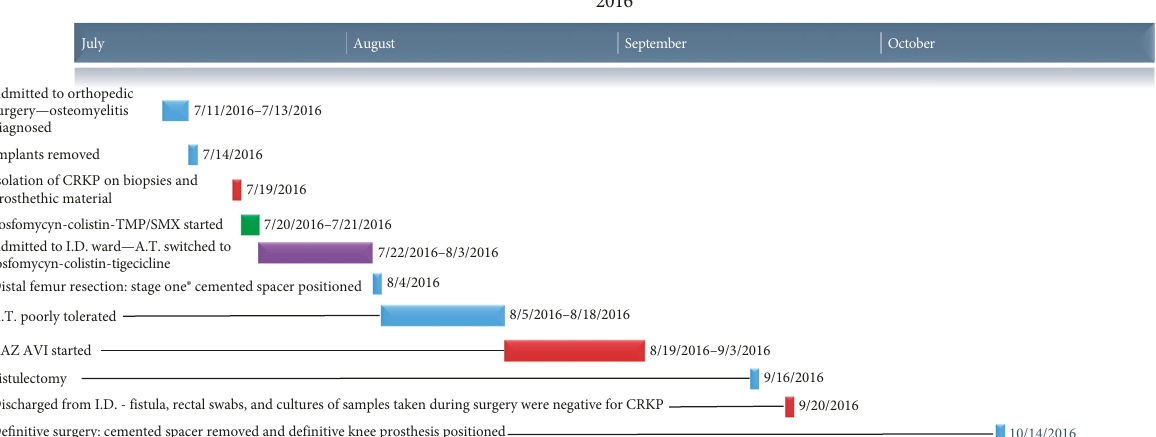
Figure 4: Timeline of antibiotic and surgical treatments.